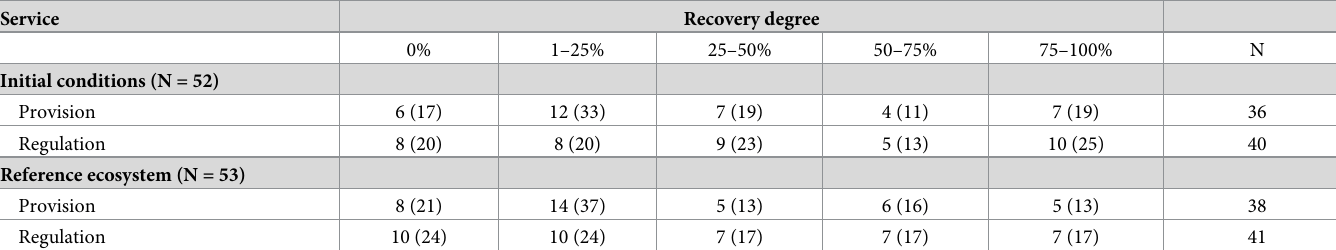
Table 2. Ecosystem services